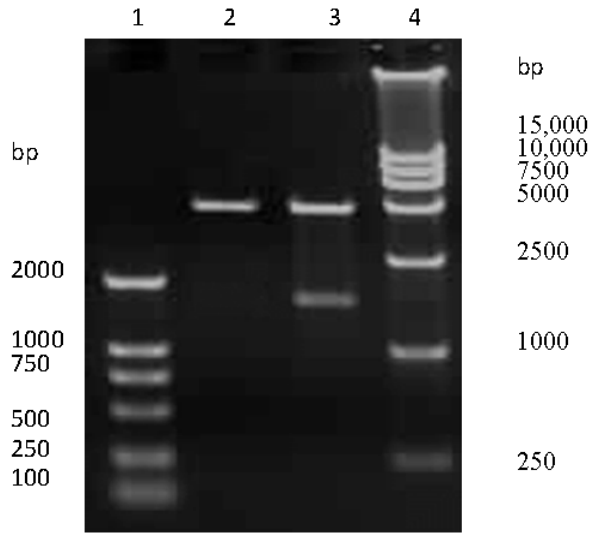
Figure 1. The recombinant pCI-neo-HA identification by Nhe I/Xho I digestion. Lane 1 and 4: DNA molecular weight marker; lane 2: empty pCI-neo plasmid; lane 3: pCI-neo-HA plasmid digested with Nhe I and Xho I.